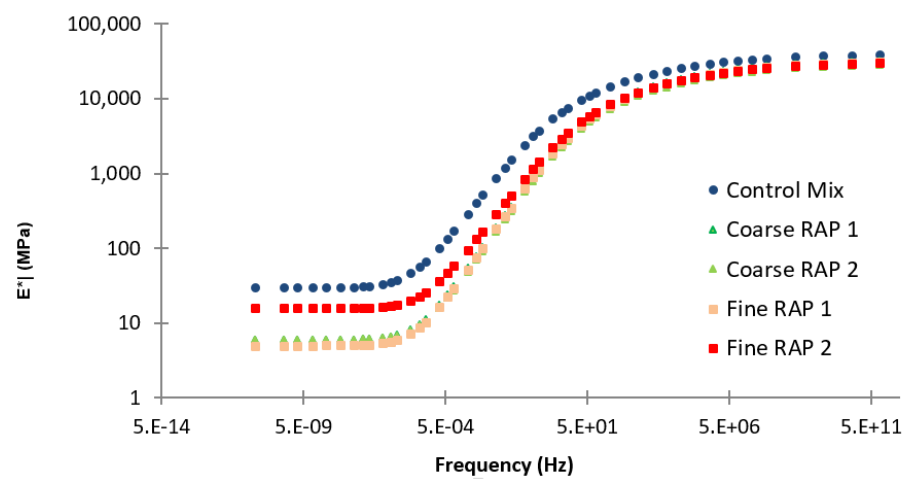
Figure 21. Master curve of the norm of complex modulus.